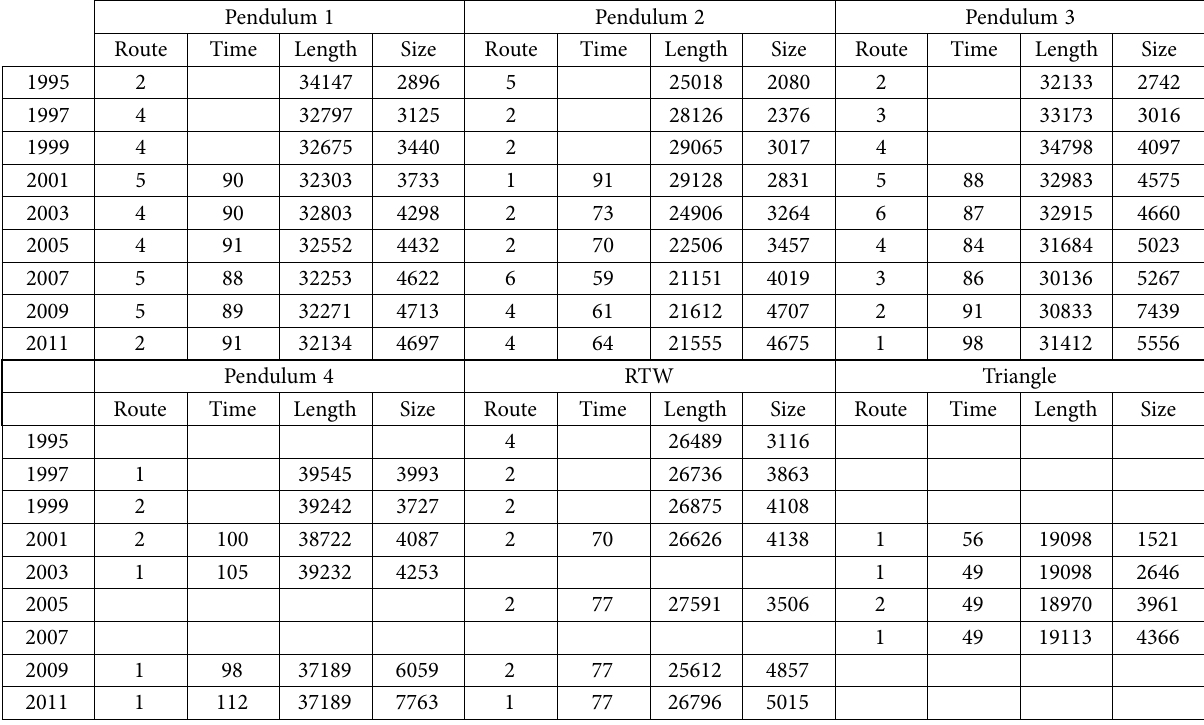
Table 4. Operational parameters of pendulum, RTW and triangle